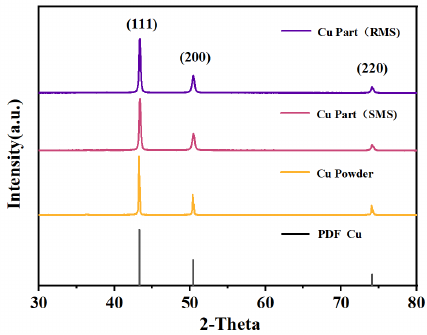
Figure 3. XRD patterns of copper powder and copper parts with SMS or RMS (laser power 350 W, initial scanning speed 200 mm/s, re ‐ scanning speed 400 mm/s, hatch spacing 0.06 mm, and layer thickness 0.05 mm).